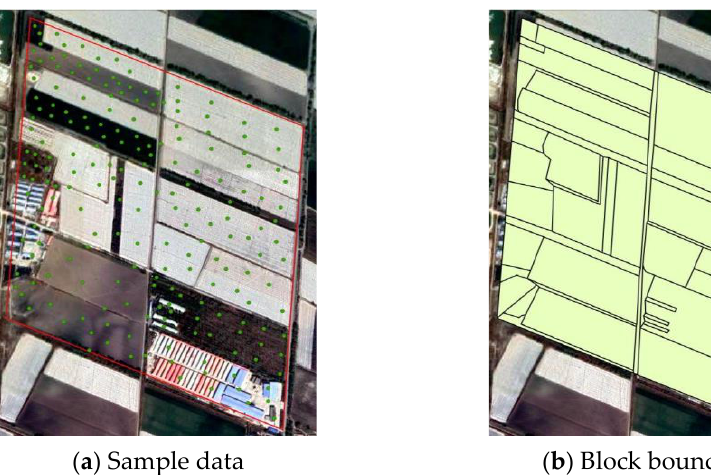
Figure 4. Spatial visualization of ground survey data.